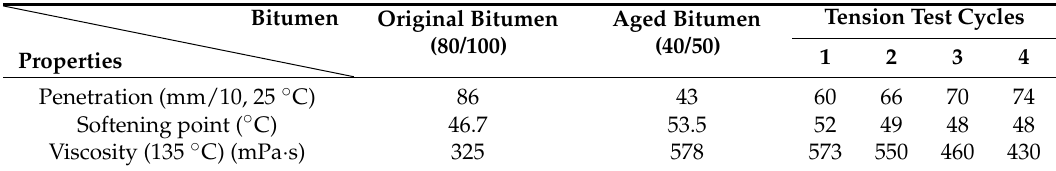
Table 2. Properties of virgin and rejuvenated bitumen (penetration value, softing point value, viscosity